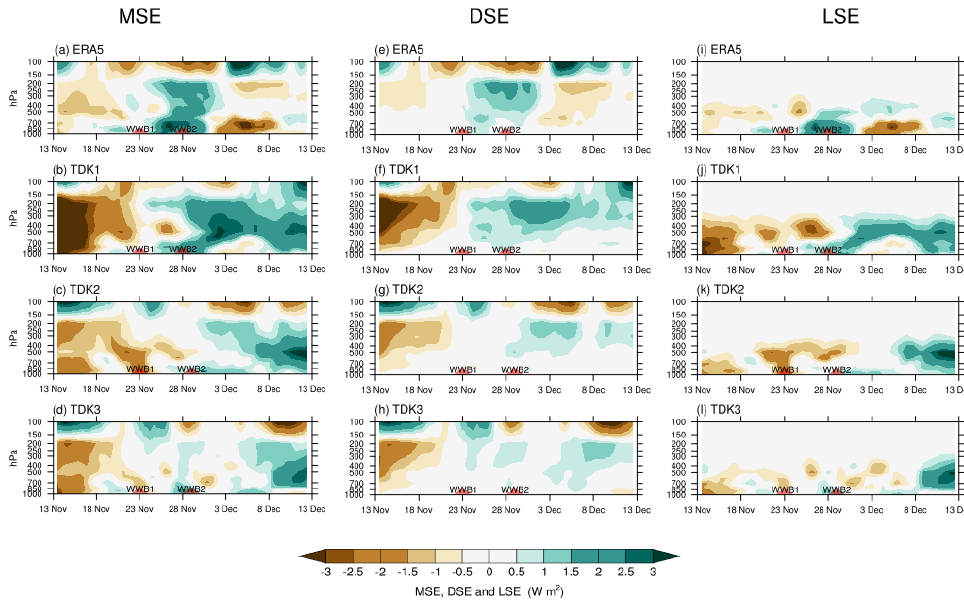
Figure 7. Time-pressure diagrams of the MSE (left panels, W m −2 ), the DSE (middle panels, W m −2 ), and the LSE (right panels, W m −2 ) over the analysis domain (10° N – 10° S, 105° E – 120° E) derived from ( a , e , i ) ERA5, ( b , f , j ) TDK1, ( c , g , k ) TDK2, and ( d , h , l ) TDK3 between 13 November and 13 December 2011. The red triangles present the time ranges when the WWB1 and WWB2 convective centers are located near the 90° E.